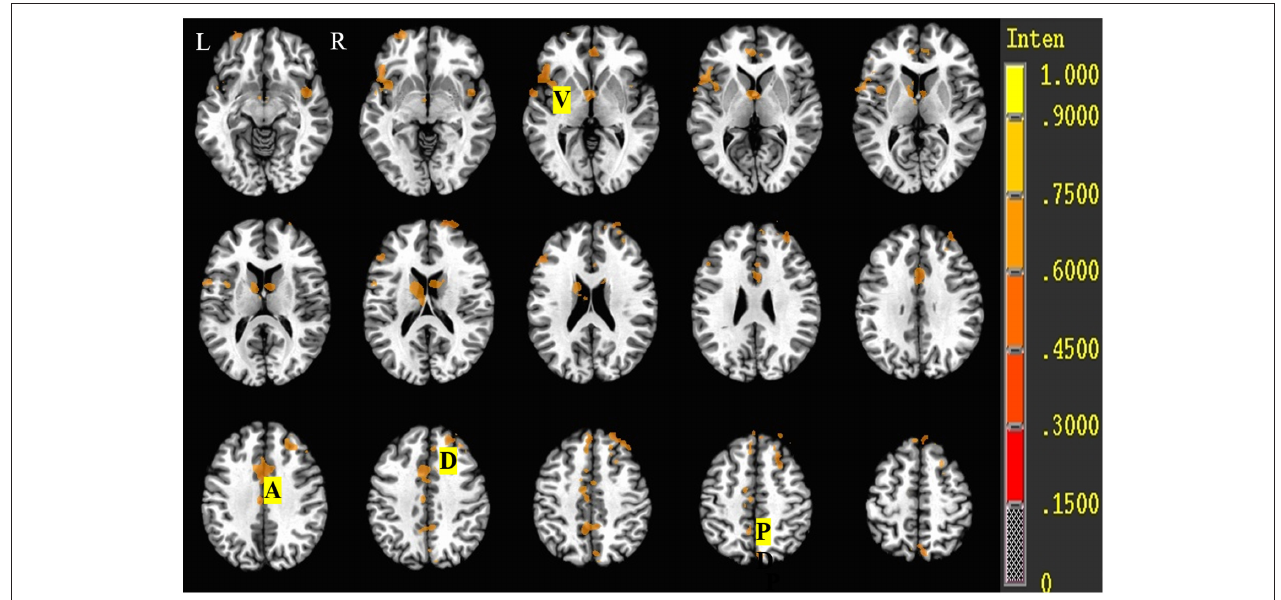
FIGURE 3 | Brain activation during the Stroop task of control and SCH groups. R, Right; L, left; D, dorsolateral prefrontal cortex (DLPFC, BA9/46); V, ventrolateral prefrontal cortex (VLPFC, BA45/47); A, anterior cingulate cortex (ACC, BA24/32); P, posterior cingulate cortex (PCC, BA23/31)/precuneus (BA7).